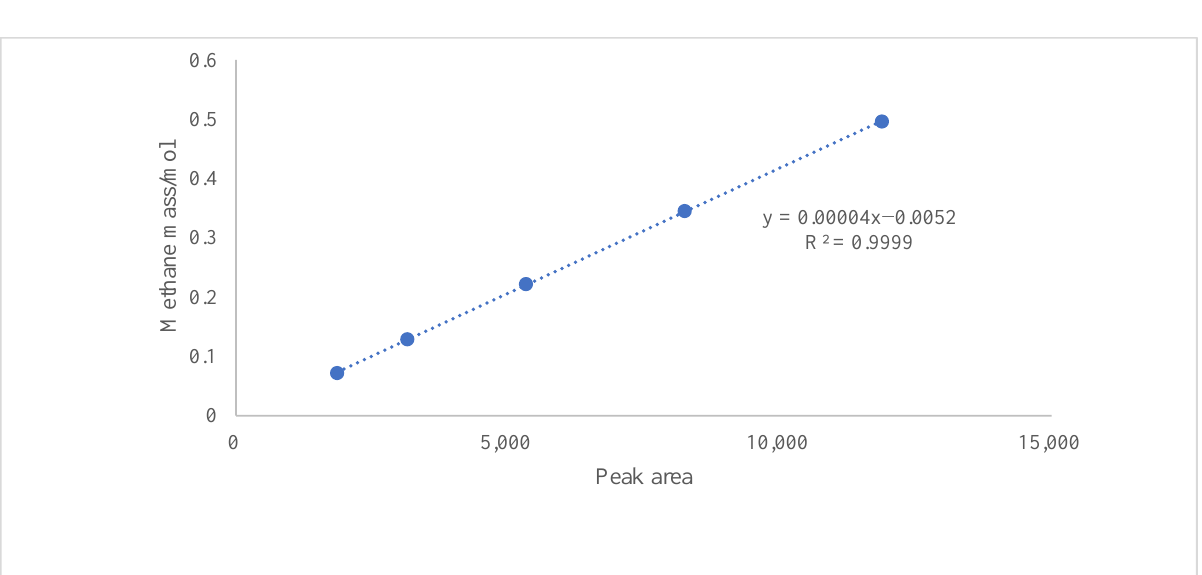
Figure 4. Conversion equation of methane marking (30 °C).